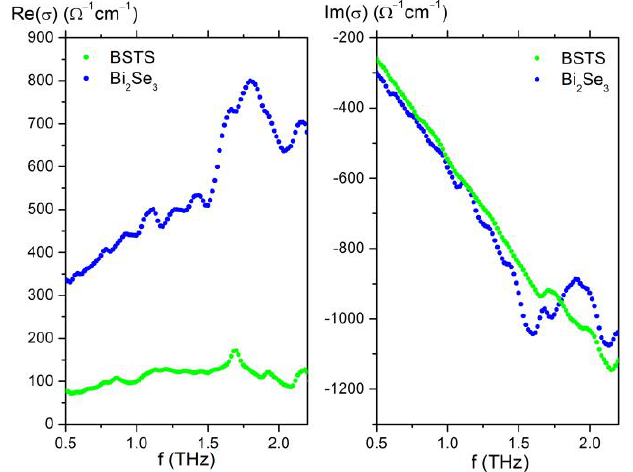
Figure 2. Frequency dependence of the real and imaginary parts of conductivity of Bi 2 Se 3 and BSTS films.